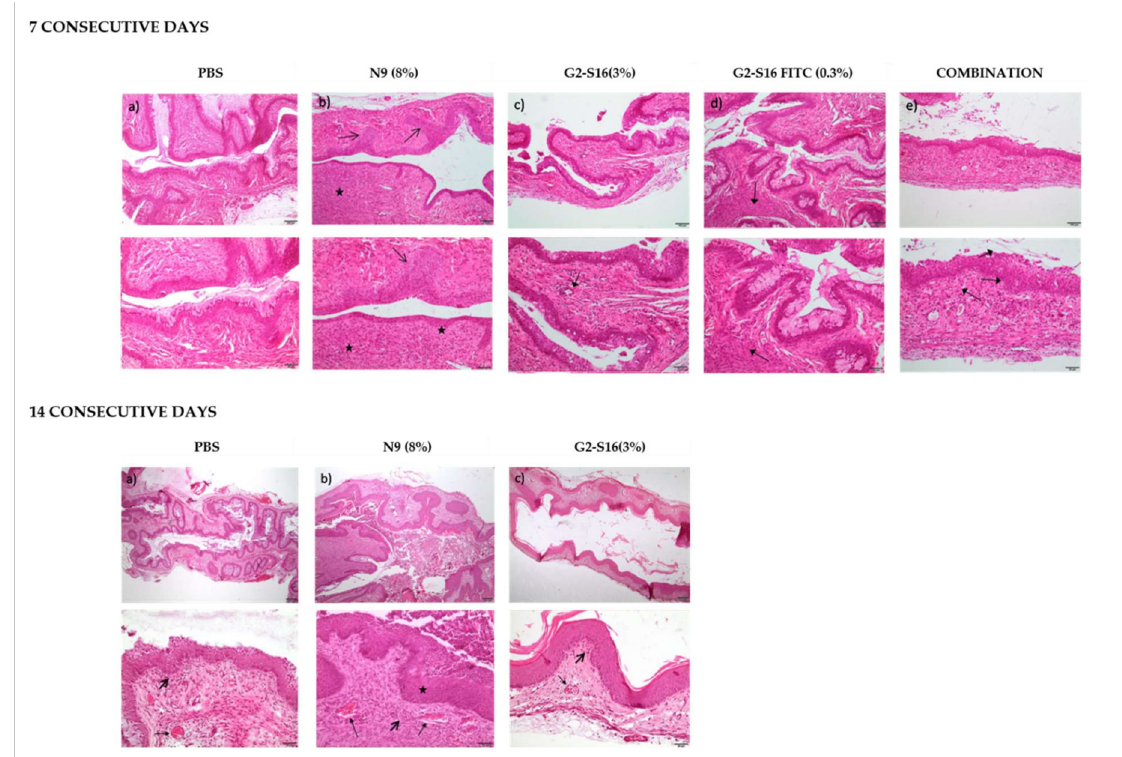
Figure 3. Histological imagens of vaginal tissue after 7 or 14 days of consecutive treatment with G2- S16 dendrimer. Upper panel. BALB/c mice were treated with 7 daily applications of ( a ) PBS, ( b ) N9, ( c ) G2-S16 dendrimer (3% w / v ), ( d ) G2-S16-FITC dendrimer (0.3% w / v ) or ( e ) a combination of G2-S16 dendrimer (2.7% w / v ) and G2-S16-FITC dendrimer (0.3% w / v ). Epithelial hyperplasia (arrows) and inflammatory infiltration and fibrosis (star) were found in the samples treated with N9 ( b ). The samples from mice treated with the G2-S16 dendrimer ( c – e ) presented some inflammatory infiltration (small arrows). The images on the bottom are zoom-ins at the images on the top. Lower panel. BALB/c mice were treated with 14 daily applications of ( a ) PBS, ( b ) N9 or ( c ) G2-S16 dendrimer (3% w / v ). We observed different degrees of vascular congestion (small arrows), inflammatory infiltration (big arrows) and epithelial hyperplasia (*). The images on the bottom are zoom-ins at the images on the